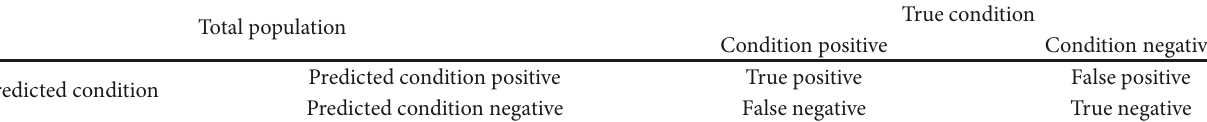
Algorithm 4: Impostor detection using the KNN. Table 2: Confusion matrix